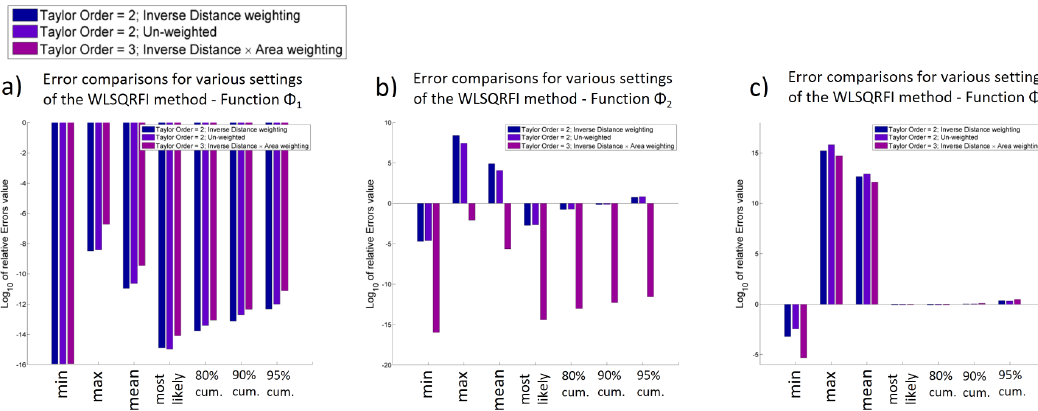
Figure 12. Comparison of GR errors for various Weighted Least Squares (WLSQR) method parameters (Taylor order = 2 & inverse-distance weighting; Taylor order = 2 & unweighted; Taylor order = 3 (16 stencil points) & inverse-distance × area weighting) for functions ( a ) φ 1 ∼ λ 2 + σ 2 ; ( b ) φ 2 ∼ λ 3 × σ 3 ; ( c ) φ 3 ∼ sin λ × cos σ